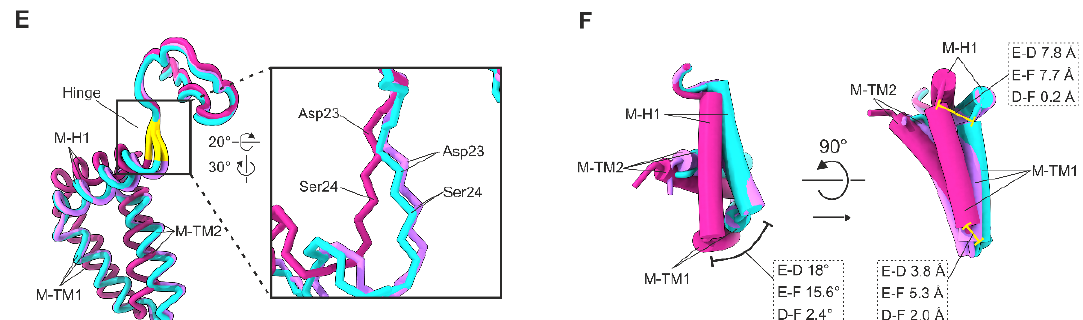
Figure 2. Quasi-equivalence within the asymmetric unit. ( A ) Surface representation of the TBEV virion. One asymmetric unit is highlighted. The symmetry axes are indicated with an ellipse (two- fold), a triangle (three-fold), and stars (five-fold). ( A – C ) The three E proteins forming the asymmetric unit are coloured in light green (chain A around the five-fold axes of symmetry), pink (chain B around the three-folds), and grey (chain C around the two-folds). ( B ) Cartoon representation of the E and M membrane-associated domains within the context of a virion. ( B – F ) The three M proteins within one asymmetric unit are coloured in purple (chain D), magenta (chain E), and turquoise (chain F). ( C ) Superimposition of the three E–M heterodimers that make up the asymmetric unit, based on the E proteins. Transmembrane helices of E are labelled as E–TM1, and E–TM2; perimembrane helices are labelled E–H1, E–H2, and E–H3. ( D ) Detailed view of the superimposed M proteins of one asymmetric unit. Transmembrane helices of M are labelled as M–TM1, and M–TM2; perimembrane helix is labelled M–H1; N-terminal loop and hinge are indicated. ( E ) Superimposition of the three M proteins in one asymmetric unit as in ( C ). The hinge between M–H1 and the N-terminal loop is highlighted in yellow and is shown zoomed in. The differences in the backbone positions at residues 23 and 24 are indicated. ( F ) Superimposition of the three M proteins in one asymmetric unit as in ( C ) with the N-terminal residues 1–21 hidden for clarity. The angles between the superimposed helices are shown in the top view (left), and the distances between the corresponding C α atoms are indicated in the side view (right).